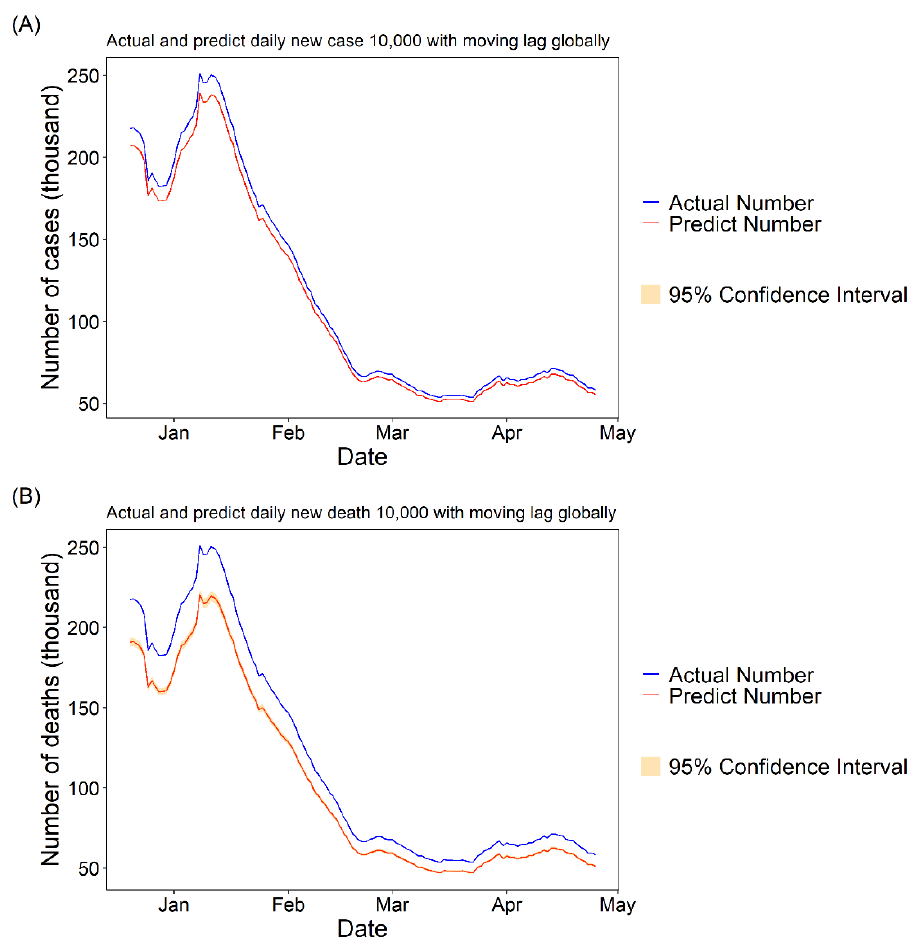
Figure 4. The actual and predicted daily cases and deaths numbers in the US. The predicted number was calculated by multiplying the actual number of daily cases by the PC value of the best lag. ( A ) The PC value and related 95% CI are − 4.84 [ − 5.02, − 4.66] with the best moving lag of 30. ( B ) The PC value and related 95% CI are − 12.31 [ − 13.53, − 11.06] with the best moving lag of 30.